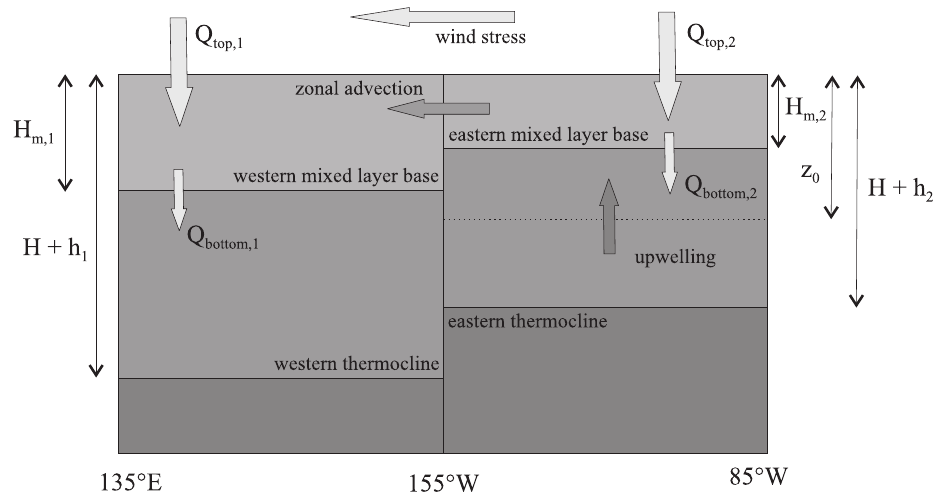
Fig. 1. Box-model of the equatorial Pacific basin. While the zonal advection and wind stress arrows in this figure point westward (indicating the typical situation), the values of u (Eq. 6) and τ x (Eq. 8) are positive for eastward directions. Table 1. Parameters relevant for the physical